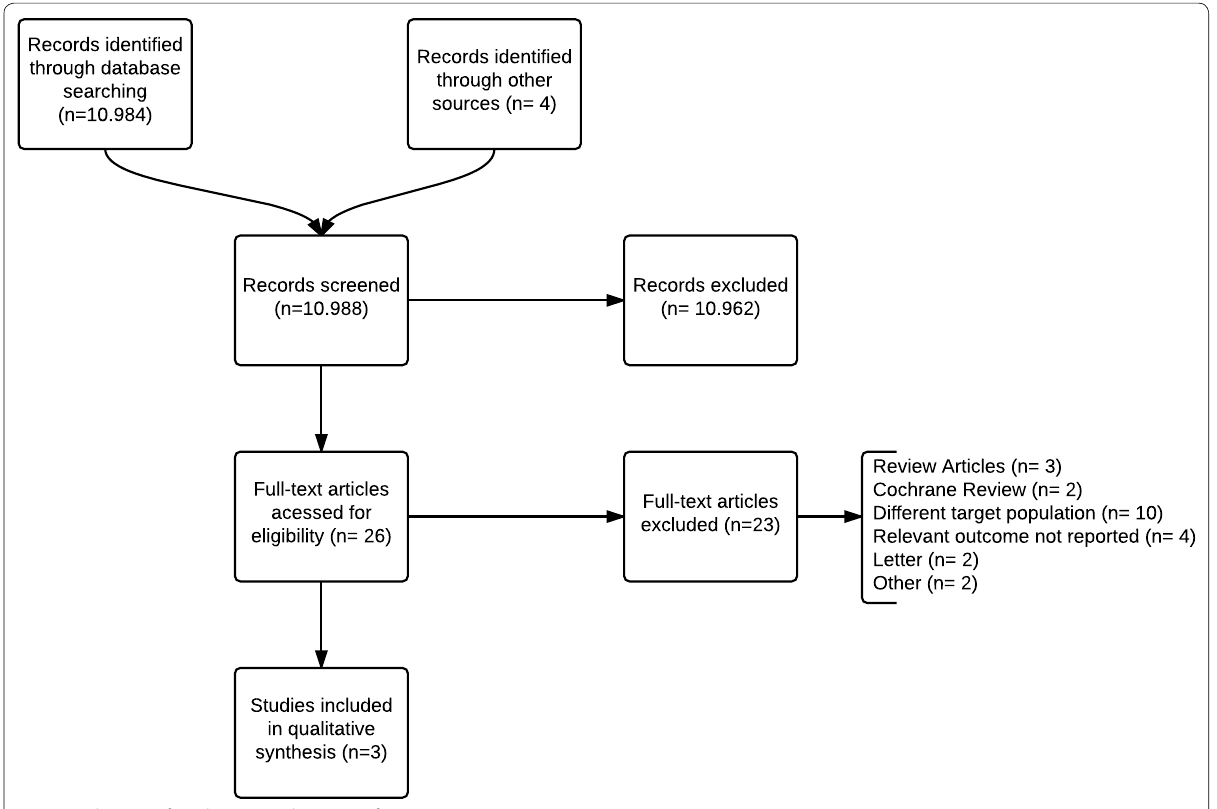
Fig. 1 Selection of studies on antibiotic use for VAP prevention in comatose